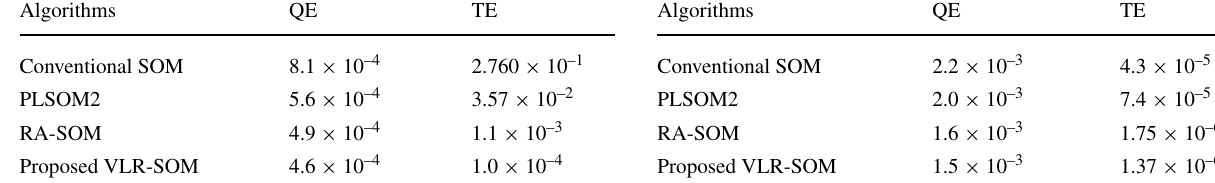
Table 2 Results for synthetic 2D data for 200 iterations Algorithms QE Conventional SOM